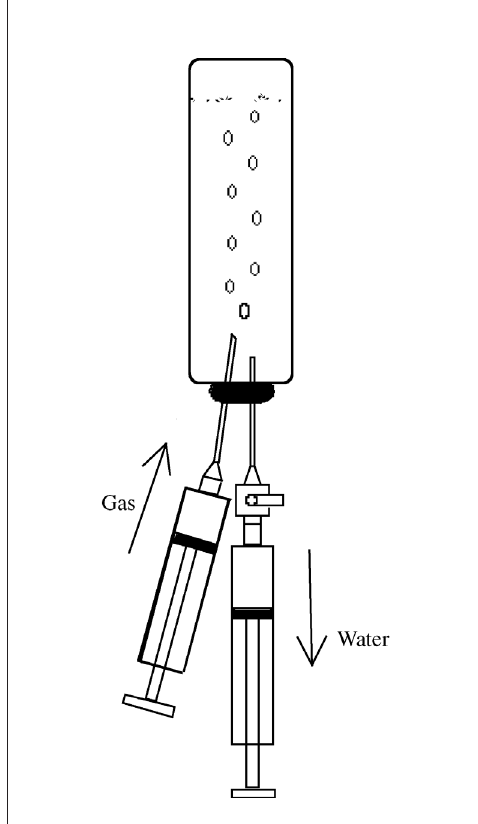
Fig. 1. Extraction of sample from sampling bottles in the laboratory. Injection of about 10 cc of pure Ar in the upturned bottles and simultaneous collection of water in a syringe with a